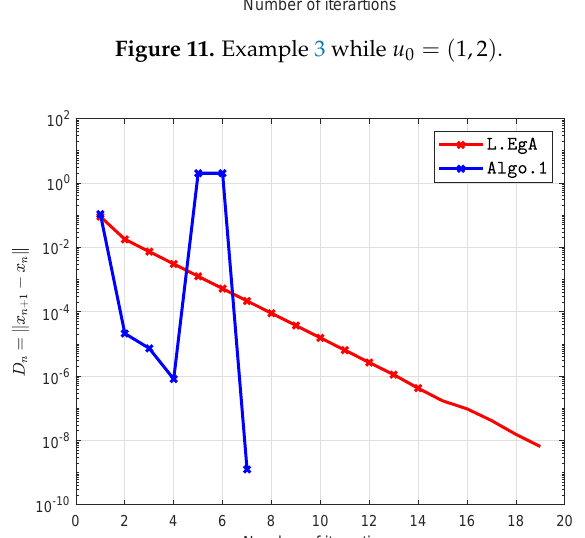
Figure 12. Example 3 while u 0 = ( 2.7,2.6 )